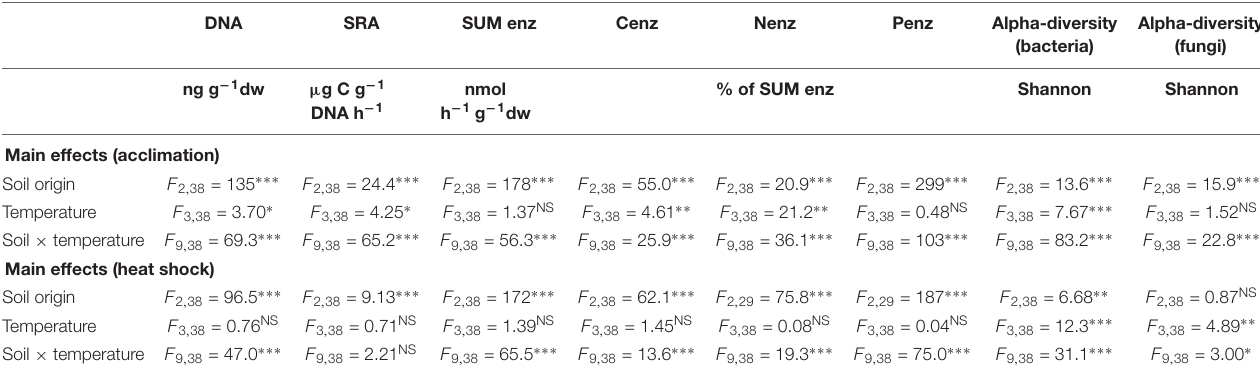
TABLE 2 | Main effects of soil origin, temperature, and their interactions on DNA content, specific respiration activity, potential enzymatic activities and bacterial and fungal Shannon-diversity Index. DNA SRA SUM enz